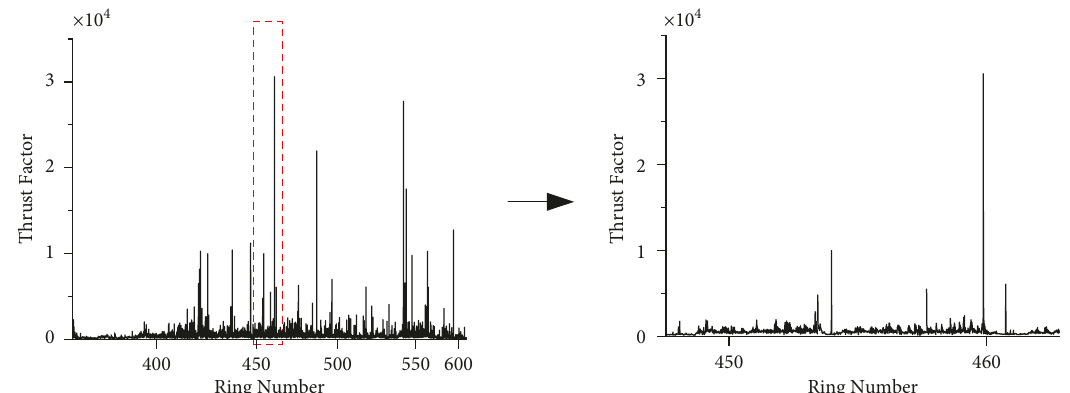
Figure 4: Time domain diagram of thrust factor and partially enlarged view.